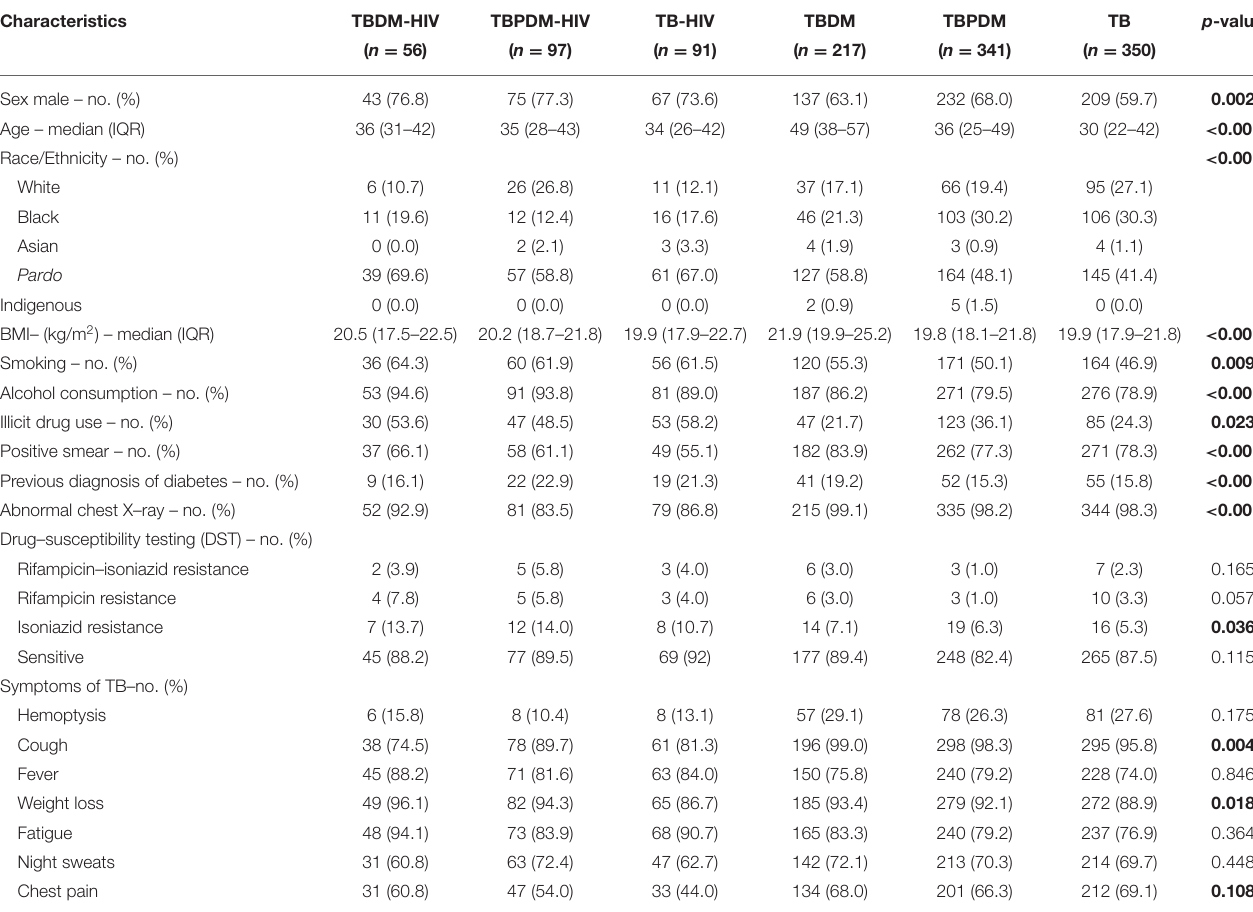
TABLE 1 | Characteristics of TB cases by DM status in RePORT-Brazil